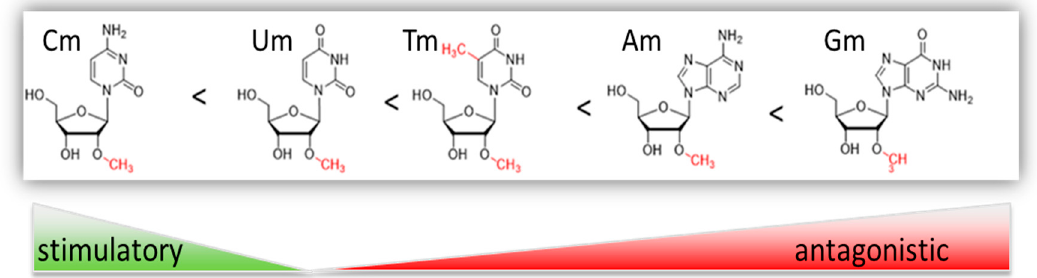
Figure 2. Immune modulatory properties of 2’- O -methylated nucleotides. Increase of nucleotide structure shifts 2’- O -methylated immune stimulatory nucleotides (cytidine) towards immune antagonistic nucleotides (adenosine, guanosine).